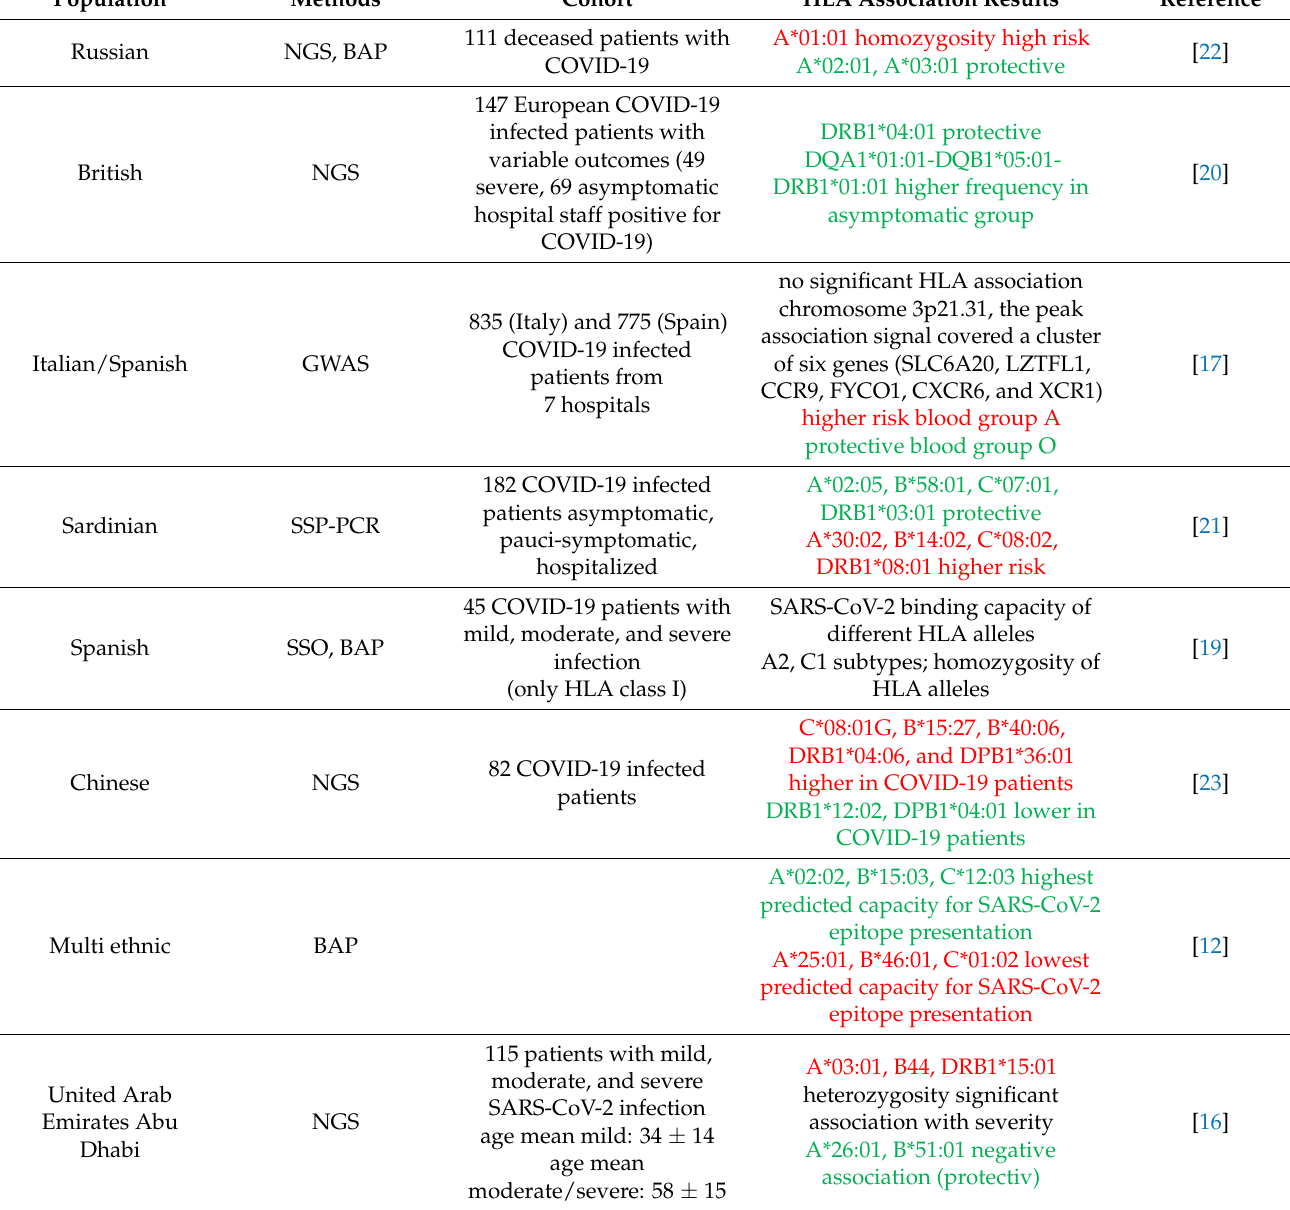
Table 2. Overview of some publications in the context of HLA and COVID-19